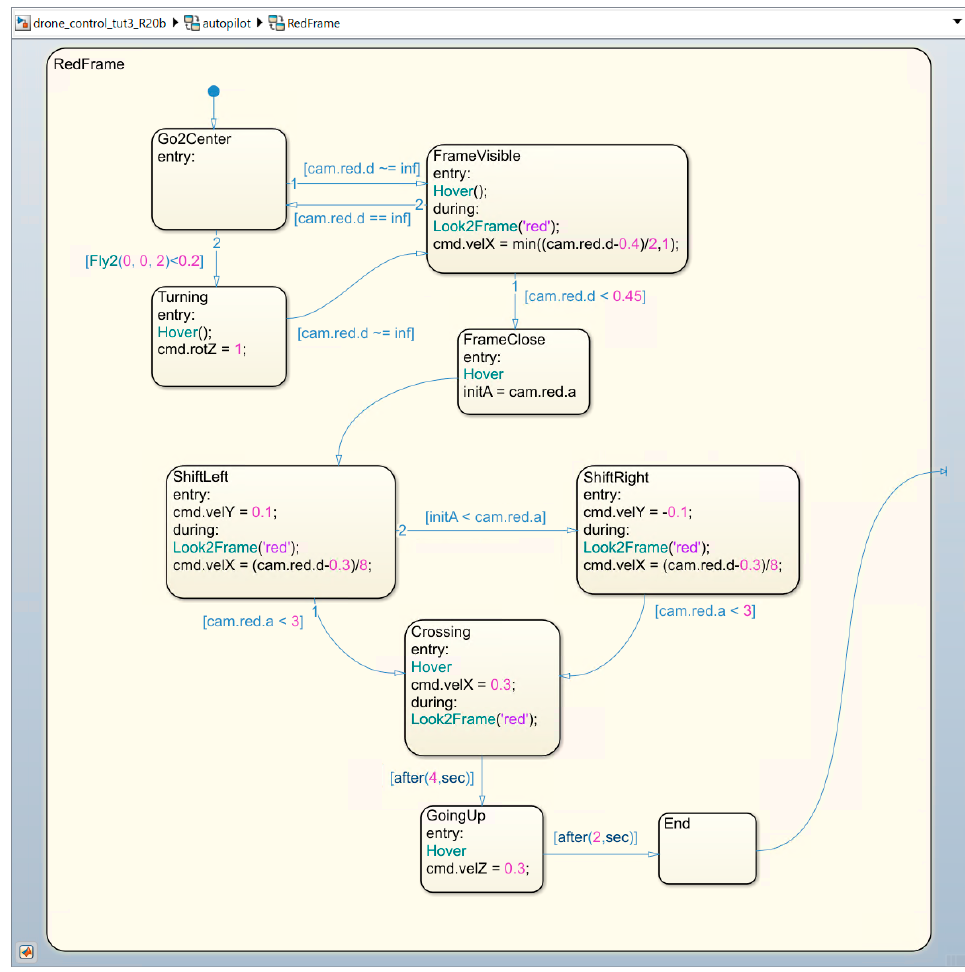
Figure 12. RedFrame Stateflow state.